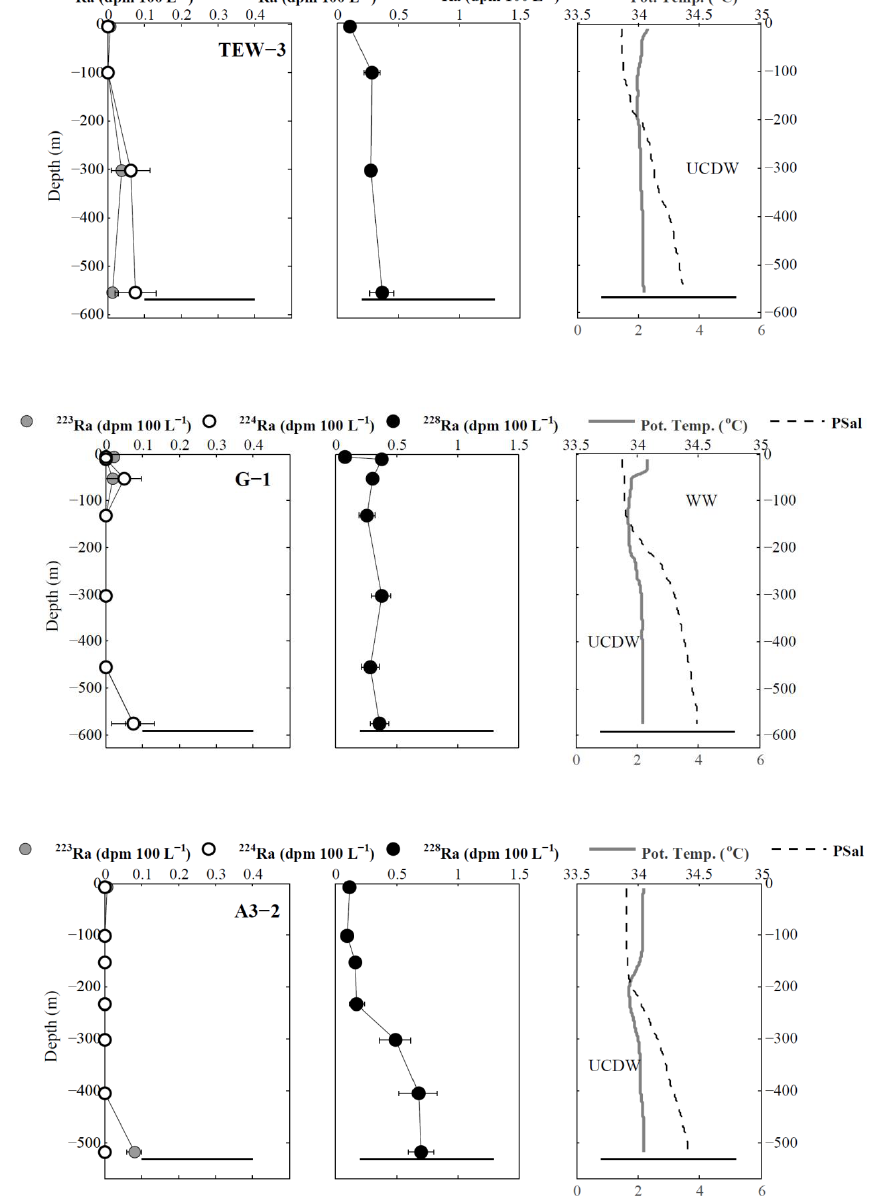
Figure 5. Vertical profiles of 223 Ra, 224 Ra and 228 Ra activities (dpm100L − 1 ) at the shallow stations. The main water masses are indicated: Winter Water (WW) and Upper Circumpolar Deep Water (UCDW). The bottom depth is denoted by the horizontal